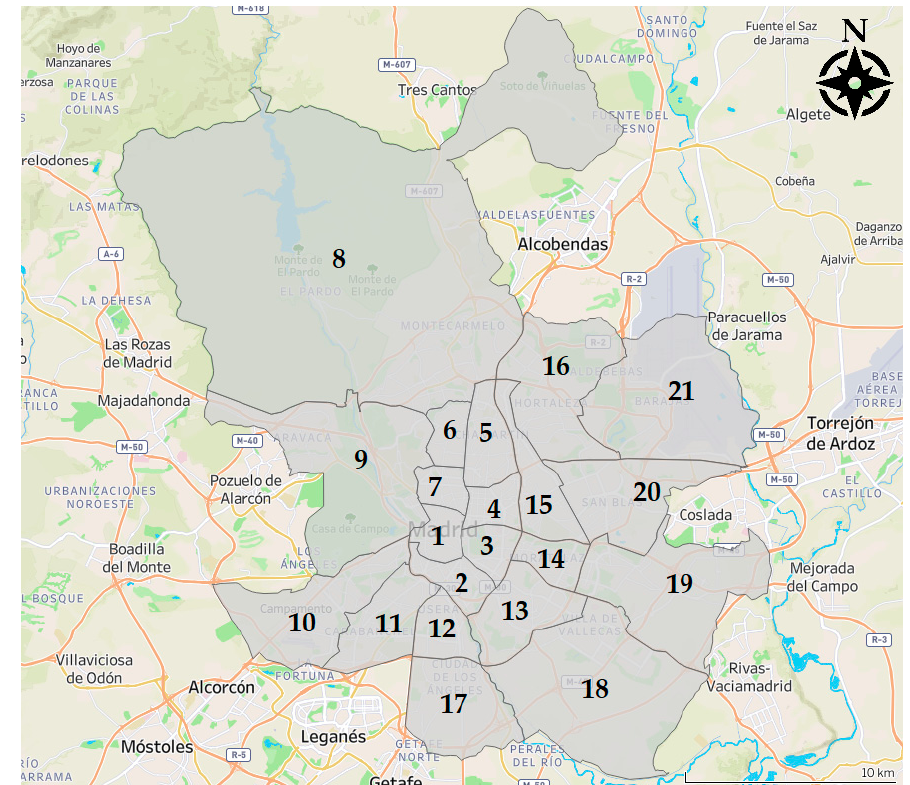
Figure 1. Districts in the city of Madrid: (1) Centro; (2) Arganzuela; (3) Retiro; (4) Salamanca; (5) Chamartín; (6) Tetuán; (7) Chamberí; (8) Fuencarral-El Pardo; (9) Moncloa-Aravaca; (10) Latina; (11) Carabanchel; (12) Usera; (13) Puente de Vallecas; (14) Moratalaz; (15) Ciudad Lineal; (16) Hortaleza;